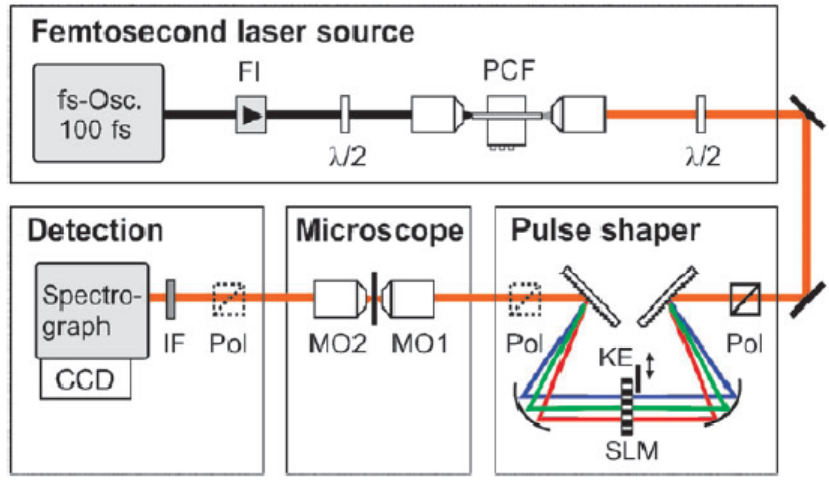
Figure 9. Experimental setup for a fs CARS measurement [57]. Details of the arrangement are discussed in the text. Briefly, broadband fs pulses are created with a standard 100 fs oscillator and broadened into a supercontinuum using a photonic crystal fiber (PCF). The pulse shaper for the CARS measurements consists of a pair of gratings, a liquid crystal spatial light modulator (SLM) and spherical mirrors. Additional system details can be found in [57]. Reprinted from von Vacano et al. [57]. Copyright 2007, American Institute of